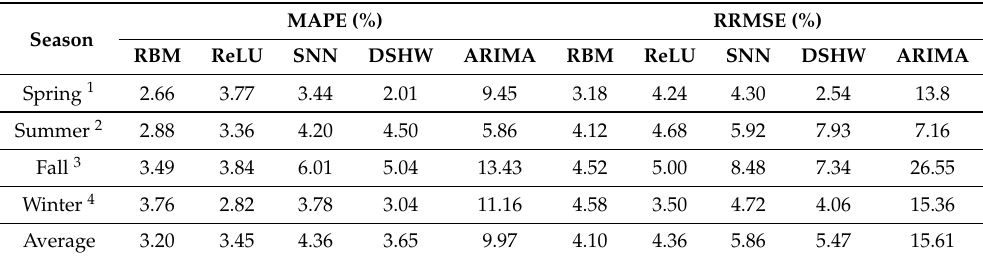
Table 2. Seasonal error table of the selected